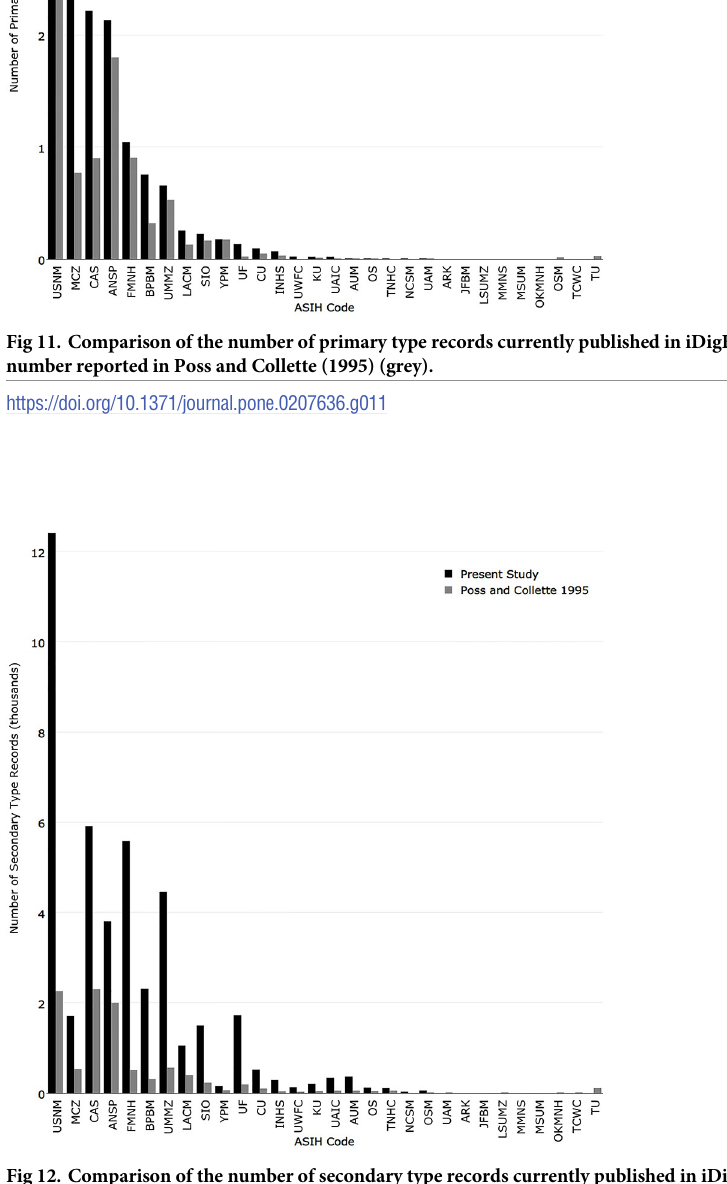
PLOS ONE | https://doi.org/10.1371/journal.pone.0207636 December19,